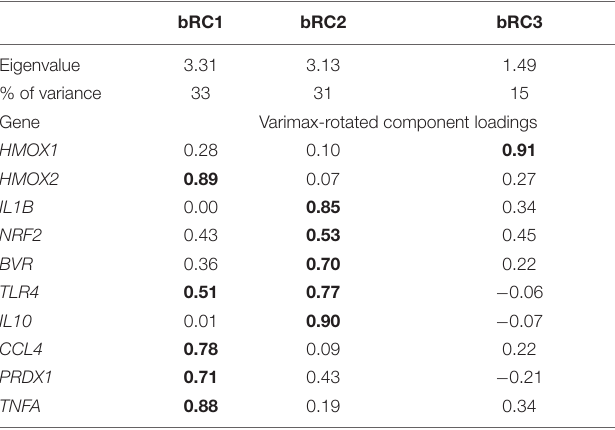
TABLE 2 | Eigenvalues and percent of explained variance for varimax-rotated components bRC1, bRC2, and bRC3 that describe expression of genes associated with inflammation, protection from oxidative stress, and production of CO in whole blood of NES. bRC1 bRC2